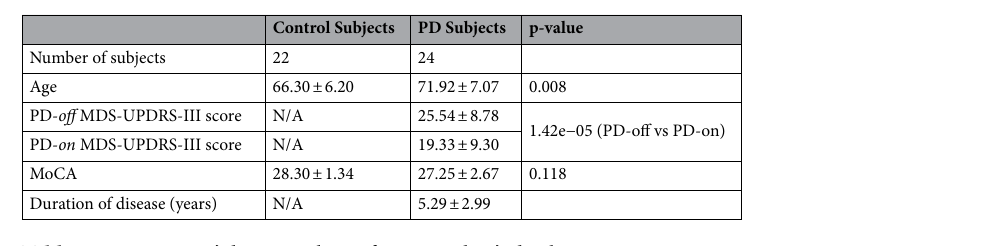
Table 2. Participants’ demographics of Viswanathan’s